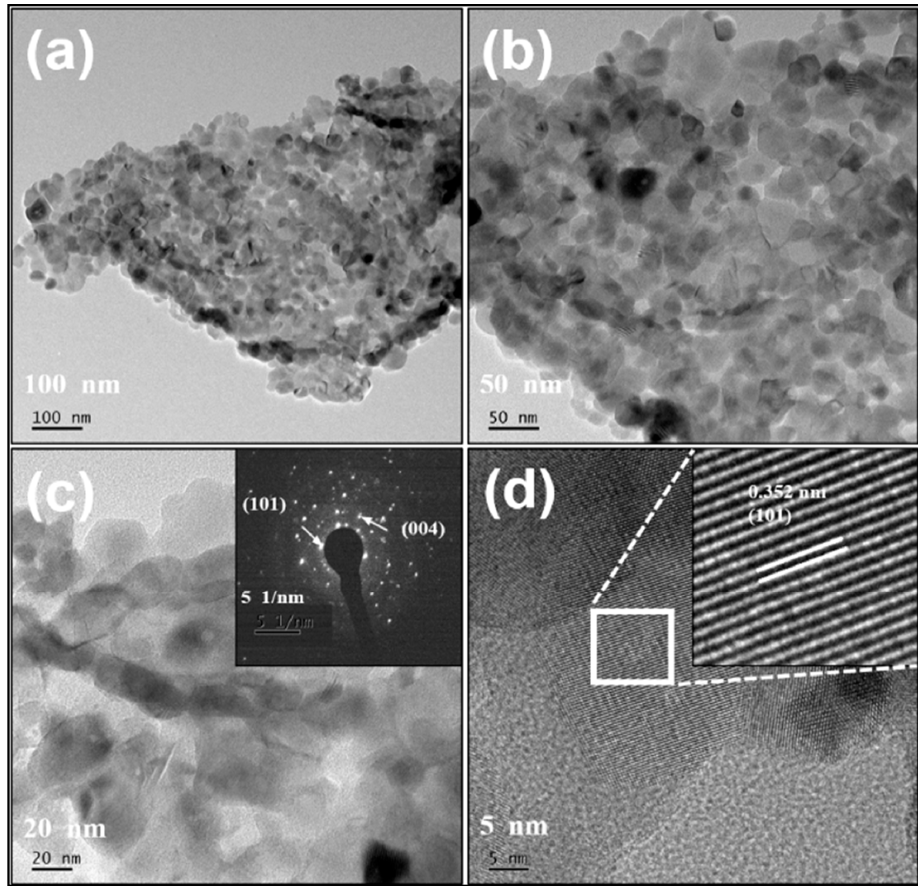
Figure 7. ( a,b ) FE-TEM images of Cu-TiO 2 (2%), insets of ( c ) and ( d ) are the SAED and high-resolution